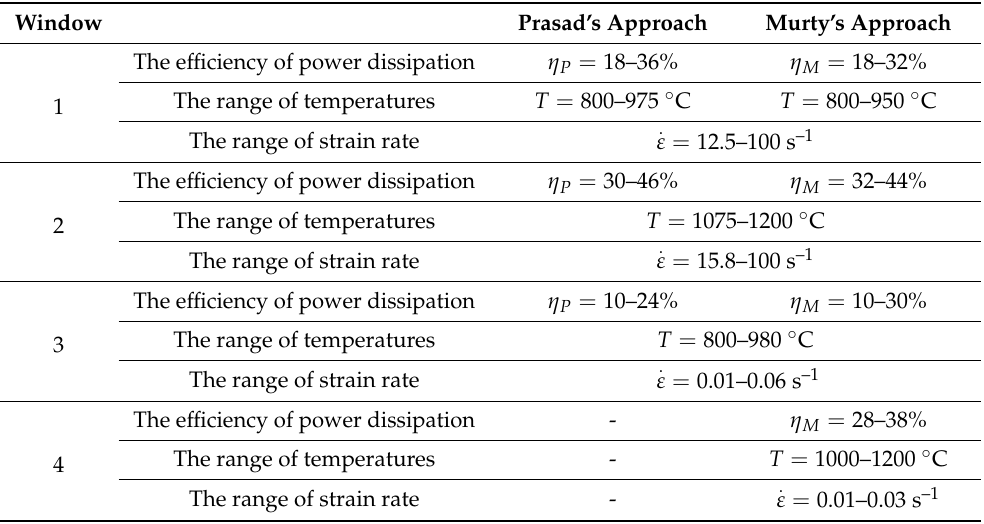
Table 2. Suggested thermomechanical processing parameters for the investigated steel, determined in processing windows for a true strain of 1 according to Prasad’s and Murty’s criterion. Window Prasad’s